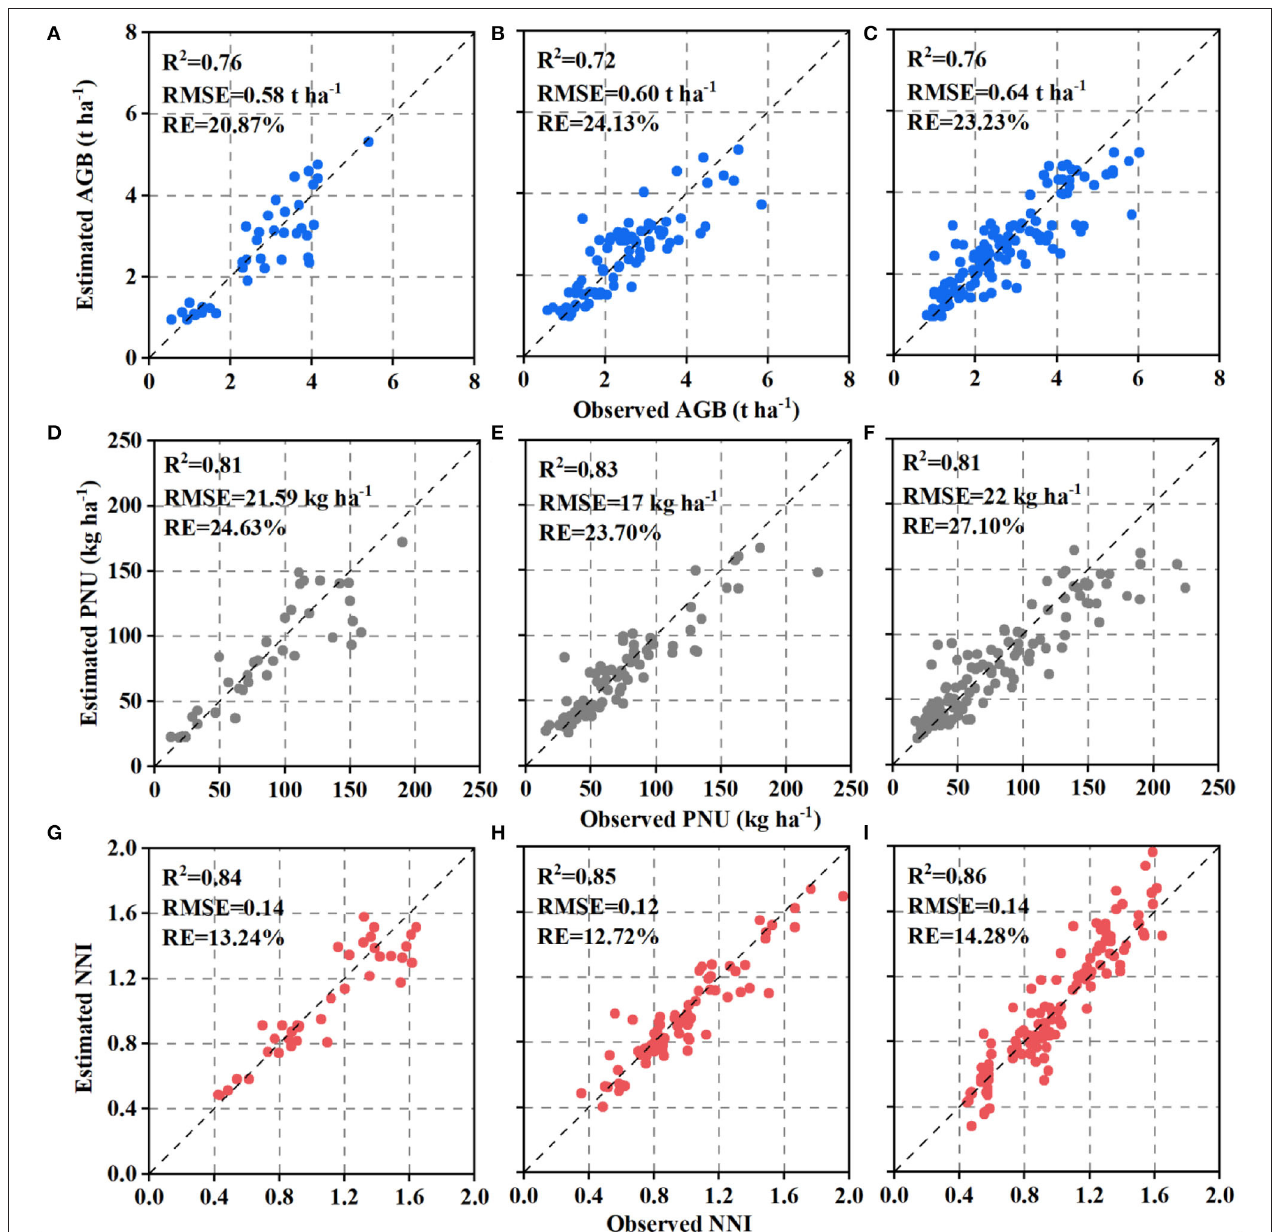
FIGURE 8 | The performance of random forest regression using the variables selected from the Pearson correlation coefficient strategy to predict the aboveground biomass (AGB), plant N uptake (PNU) and N nutrition index (NNI) in agro-ecological zones 1 (A,D,G) , agro-ecological zone 2 (B,E,H) and two agro-ecological zones (C,F,I) . The black dotted line is the 1:1